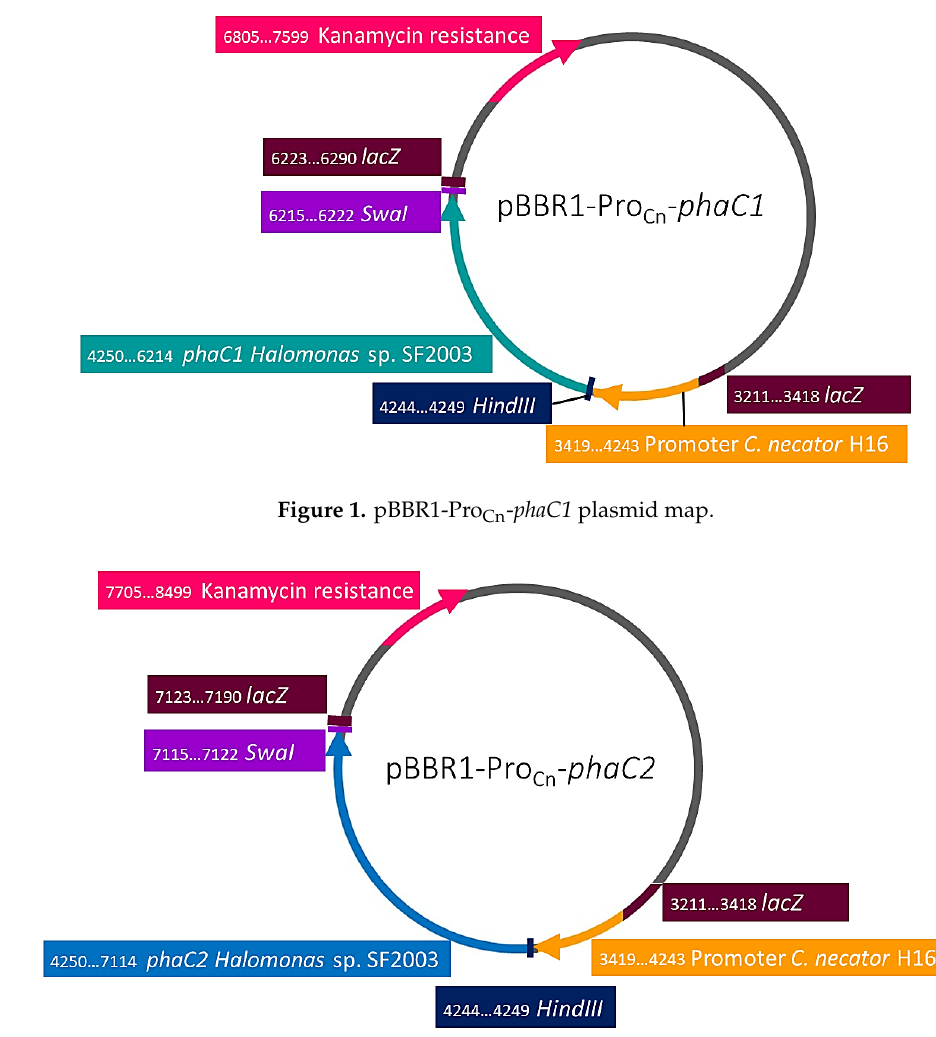
Figure 2. pBBR1-Pro Cn - phaC2 plasmid map.